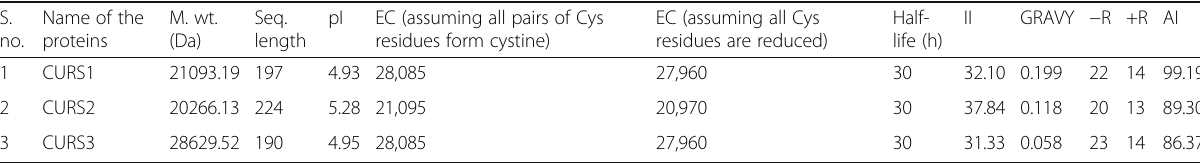
Table 1 Physicochemical properties of CURS proteins S. Name of the no. proteins